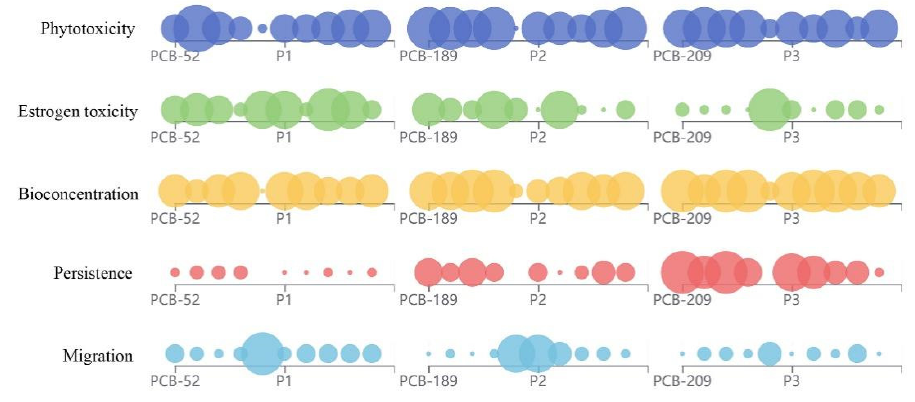
Figure 6. Changes in the environmental characteristics of PCB conversion products.